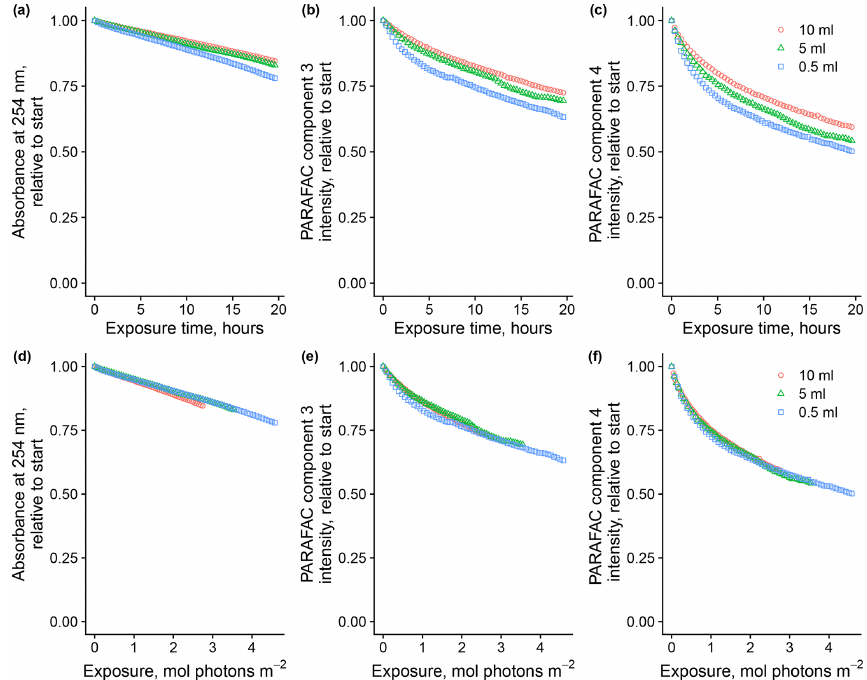
Figure 3. Photodegradation time series of absorbance at 254nm and fluorescence intensities of PARAFAC components three and four relative to starting values. Data are shown from experiments with SRNOM PPL that varied the volume of the sample added to the mixing reactor (after filling flow cell lines). Panels (a) – (c) show the values as a function of exposure time, while panels (d) – (f) show the values as a function of cumulative photon exposure calculated from NO 2 / NO 3